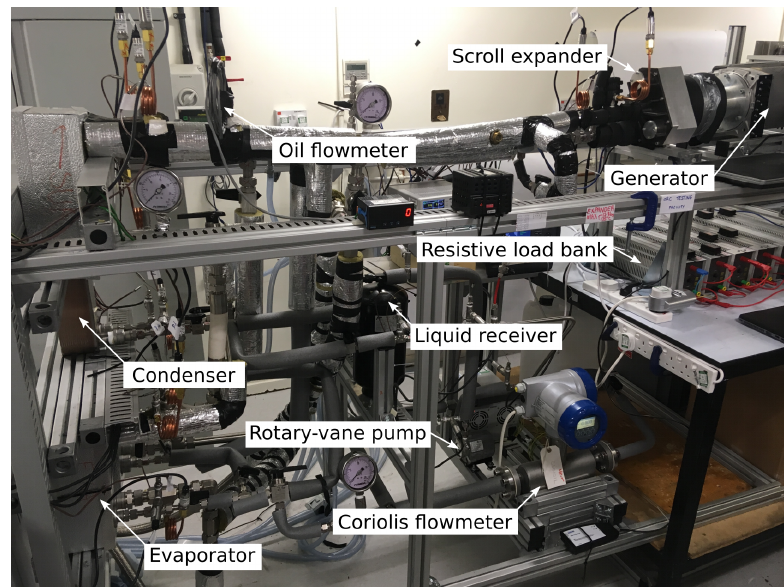
Figure 2. Picture of the experimental testing